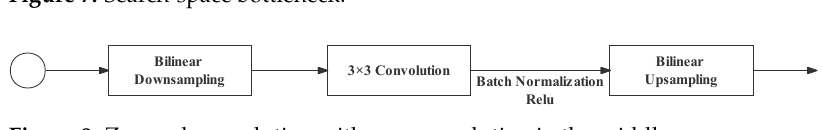
Figure 7. Search-space bottleneck.